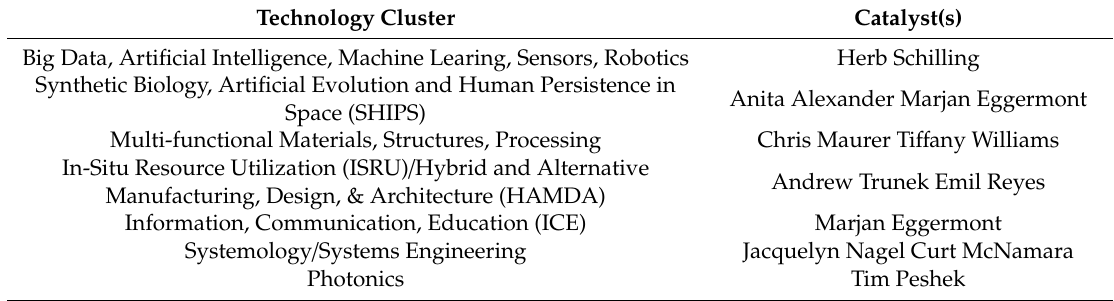
Table 6. Virtual Interchange for Nature-inspired Exploration (V.I.N.E.) clusters and points of contact as of 1/31/2019.